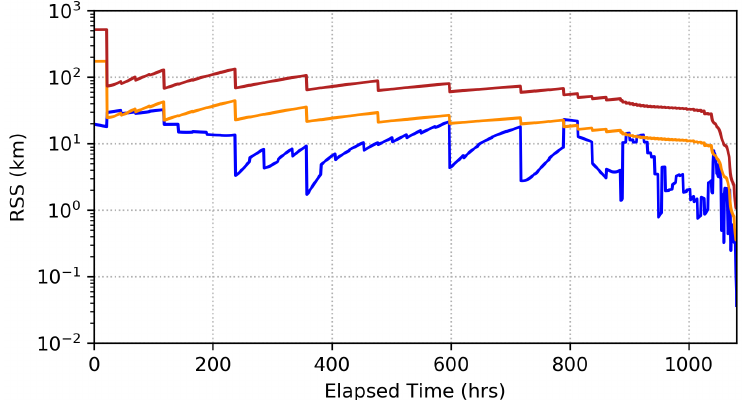
Figure 17. Position error (blue) and RTPC uncertainty (1- σ (orange) and 3- σ (red)) for optical-only filter with attitude thruster